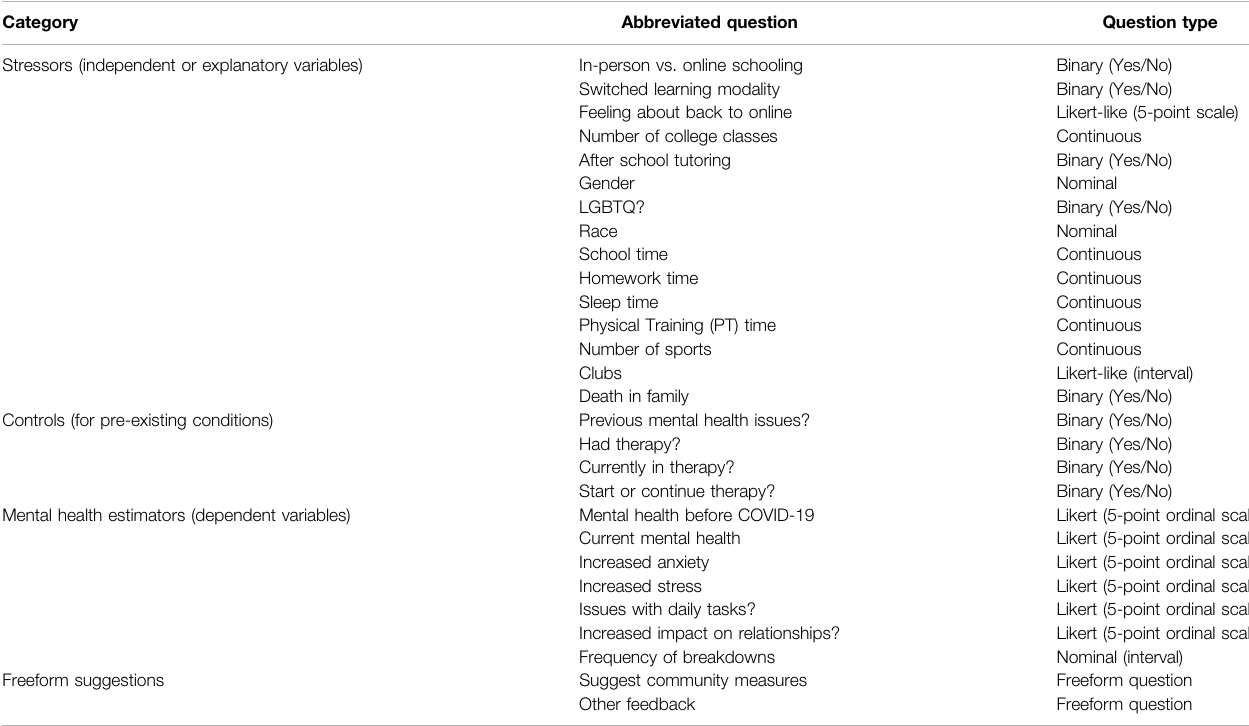
TABLE 1 | Category and summary of parameters included in our instrument. Full questionnaire is included in the supplementary materials. Category Stressors (independent or explanatory